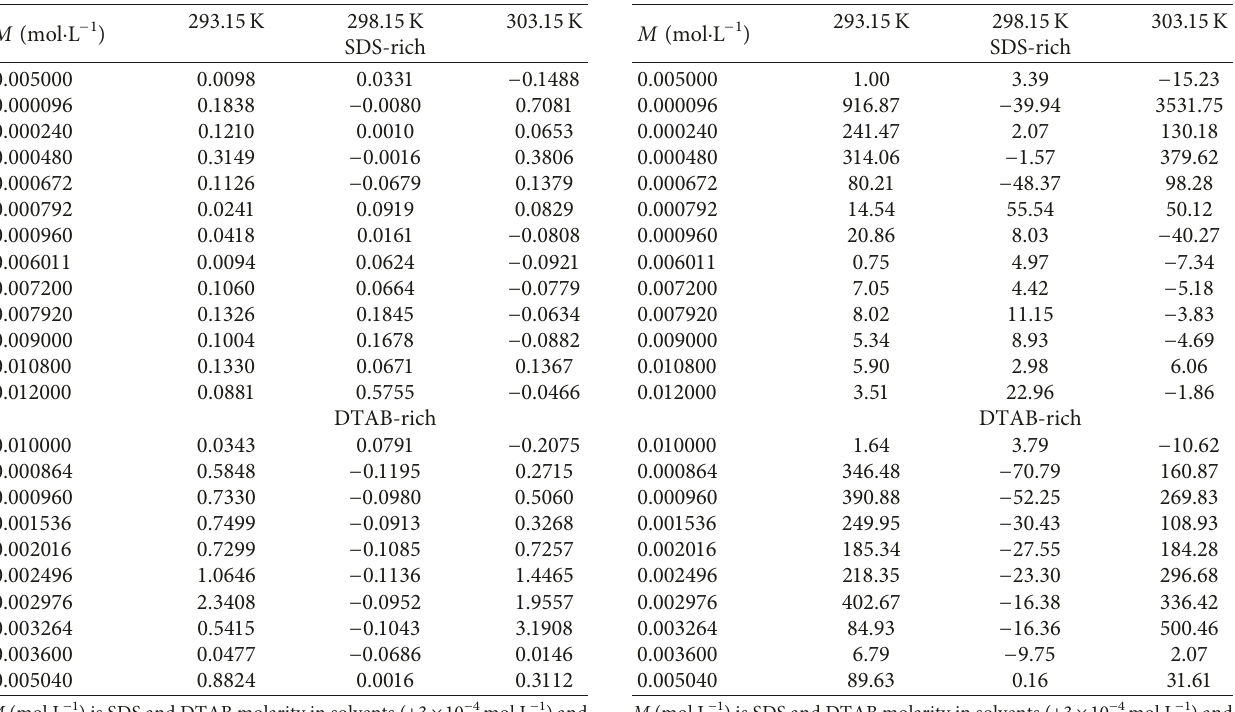
Table 8: Fractional volume ( ϕ ) of SDS-rich and DTAB-rich sur- factants in the aqueous medium at the three different temperatures